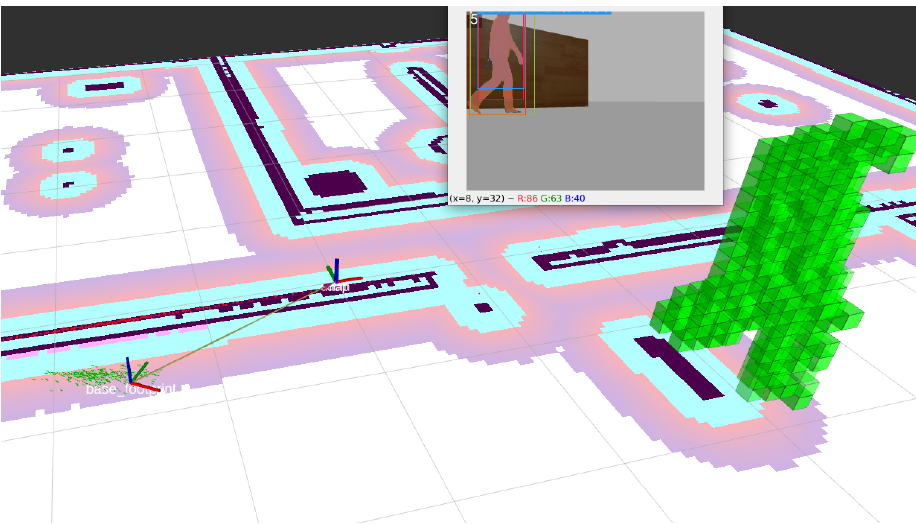
Figure 7. Instantaneous perception O t from the 3D segmentation process. Perceptions O t are located in the frame of the sensor with which they were captured. If a robot is located, it is possible to obtain each cell of the octomap in the frame